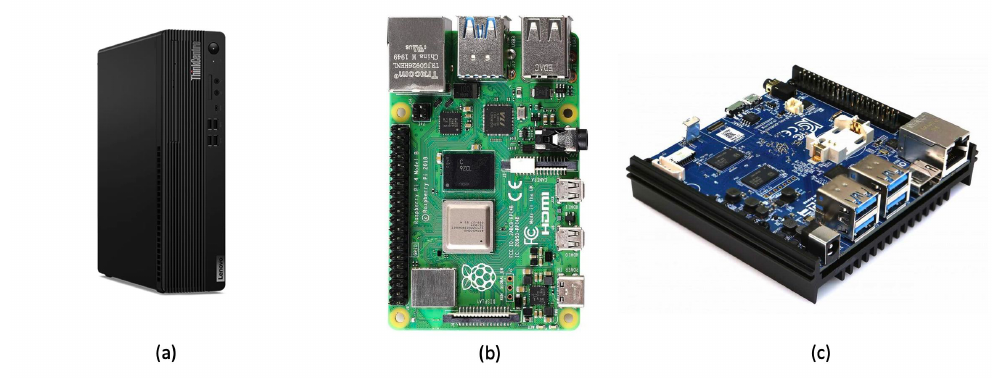
Figure 3. Elaboration units (Lenovo ThinkCentre ( a ), Raspberry Pi 4 Model B ( b ), Odroid N2+ ( c )) for the acquisition, processing accelorometer data and classification of human